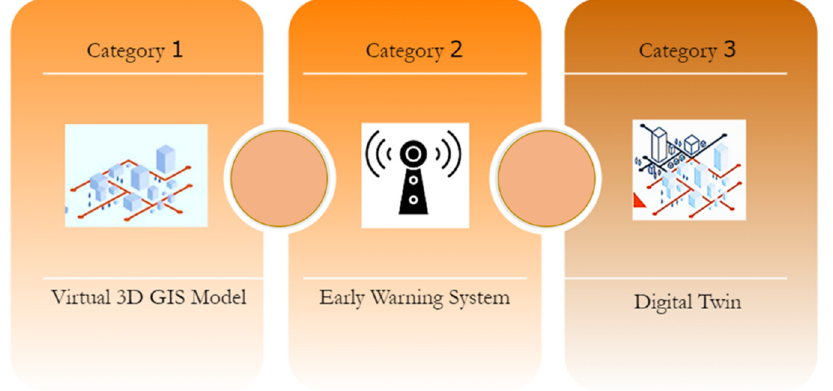
Figure 6. Key themes Identified for Study: A visual overview